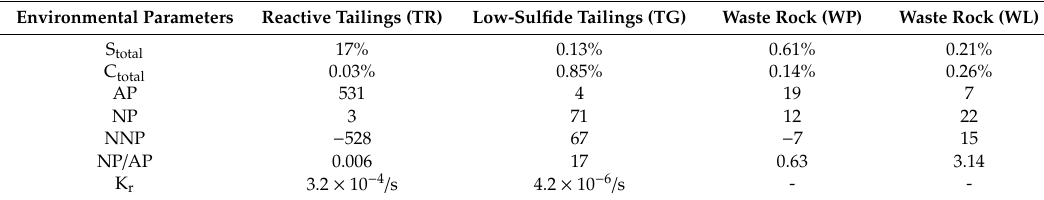
Table 3. Environmental characteristics of reactive tailings and cover materials. Environmental